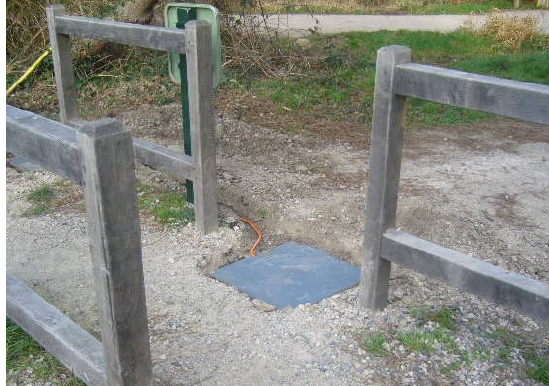
Figure 7. Eco Counter ‘SLAB’ installed at a pedestrian pinch point.